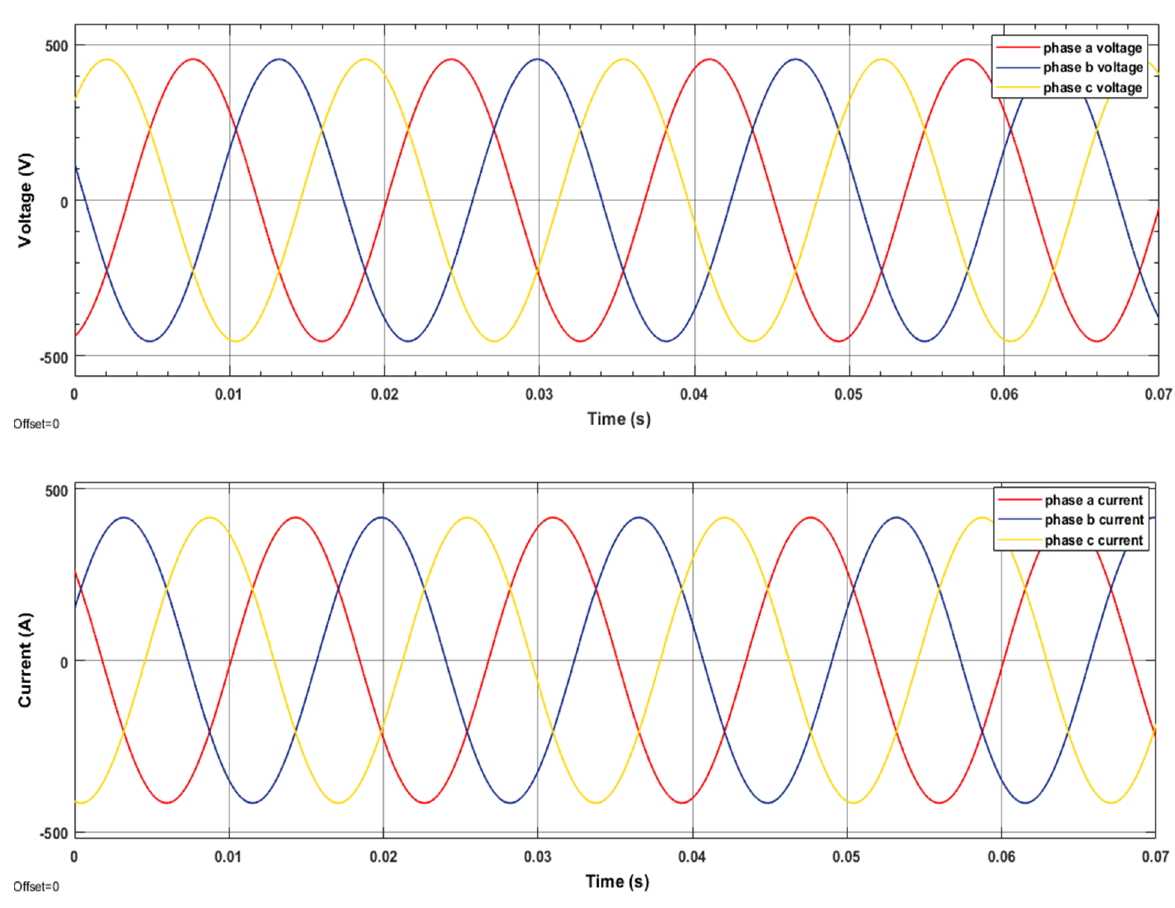
Figure 12. Phase to phase voltage and current as calculated in Equation (16).